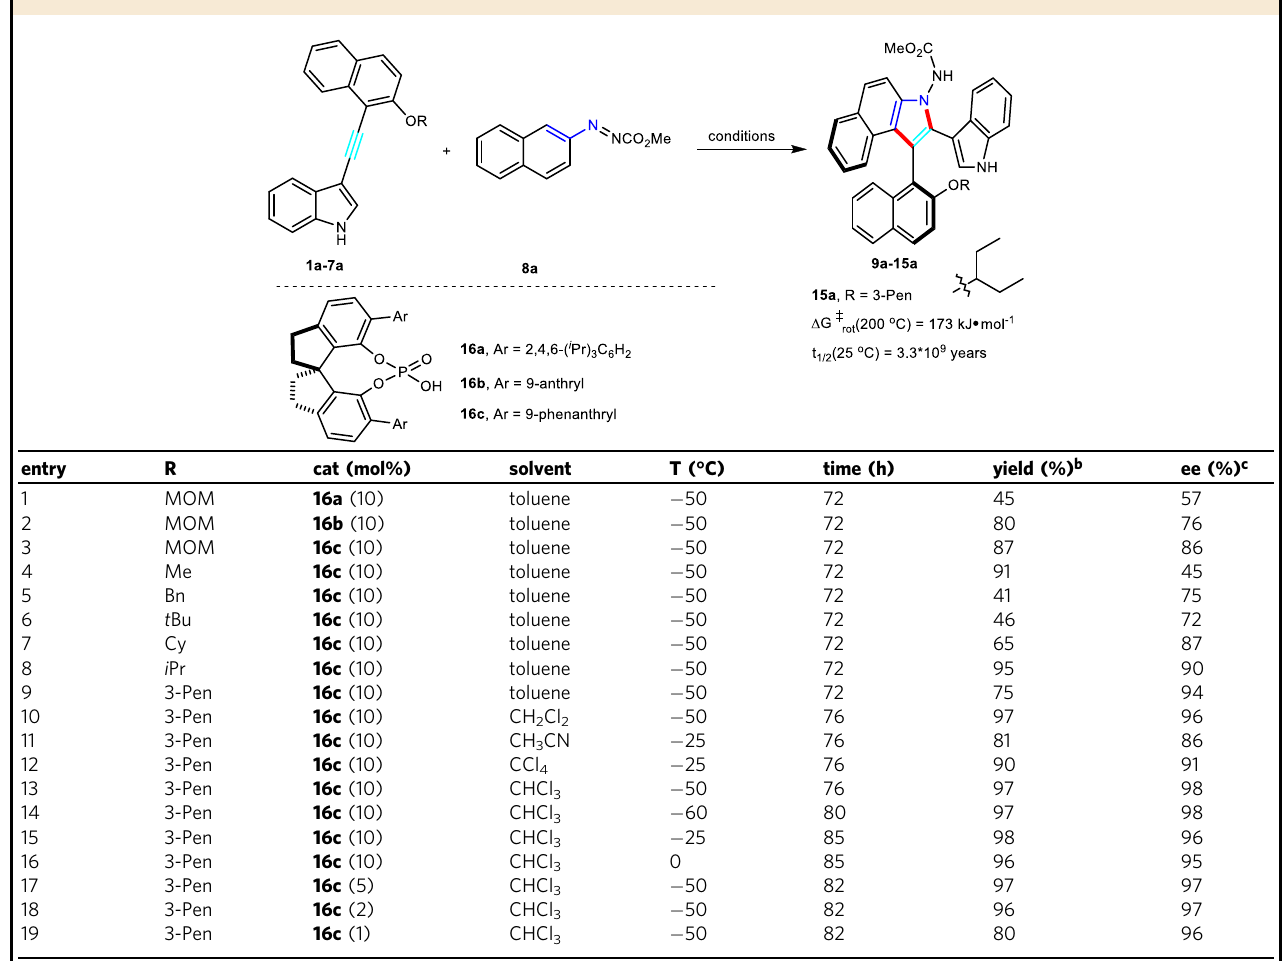
Table 1 Optimization of the reaction conditions a